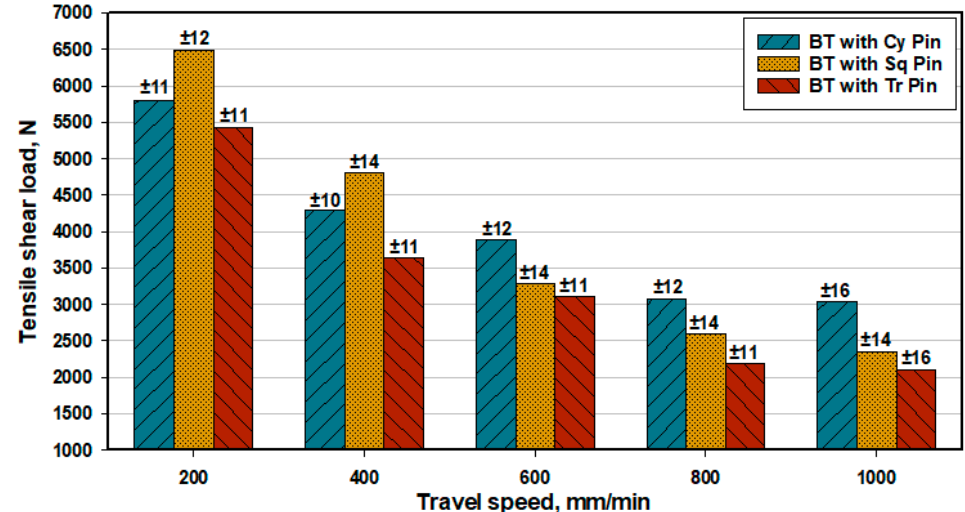
Figure 21. Tensile-shear loads of BT-FSW lap joints at various travel speeds using different pin geometries.